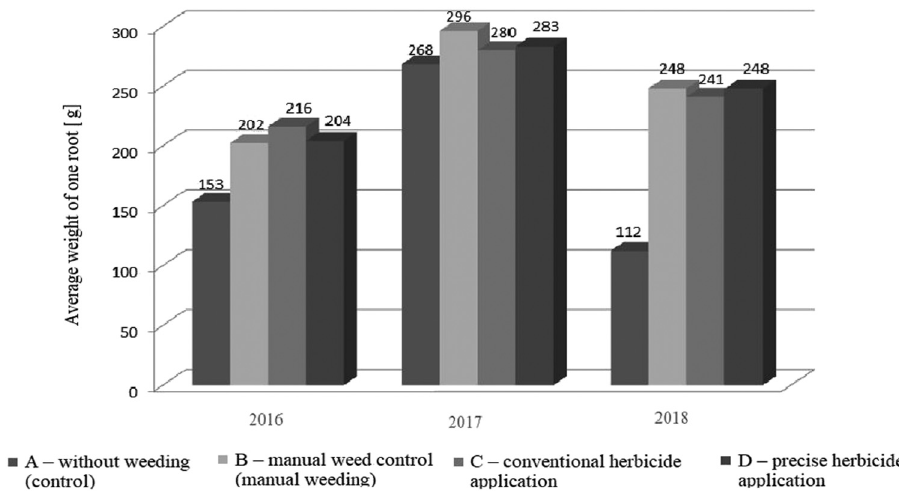
Figure 5: Qualitative assessment of carrot commercial yield ( ∅ ≥ 30 mm ) in terms of the average weight of one root in 2016 – 2018 ( source: own work )